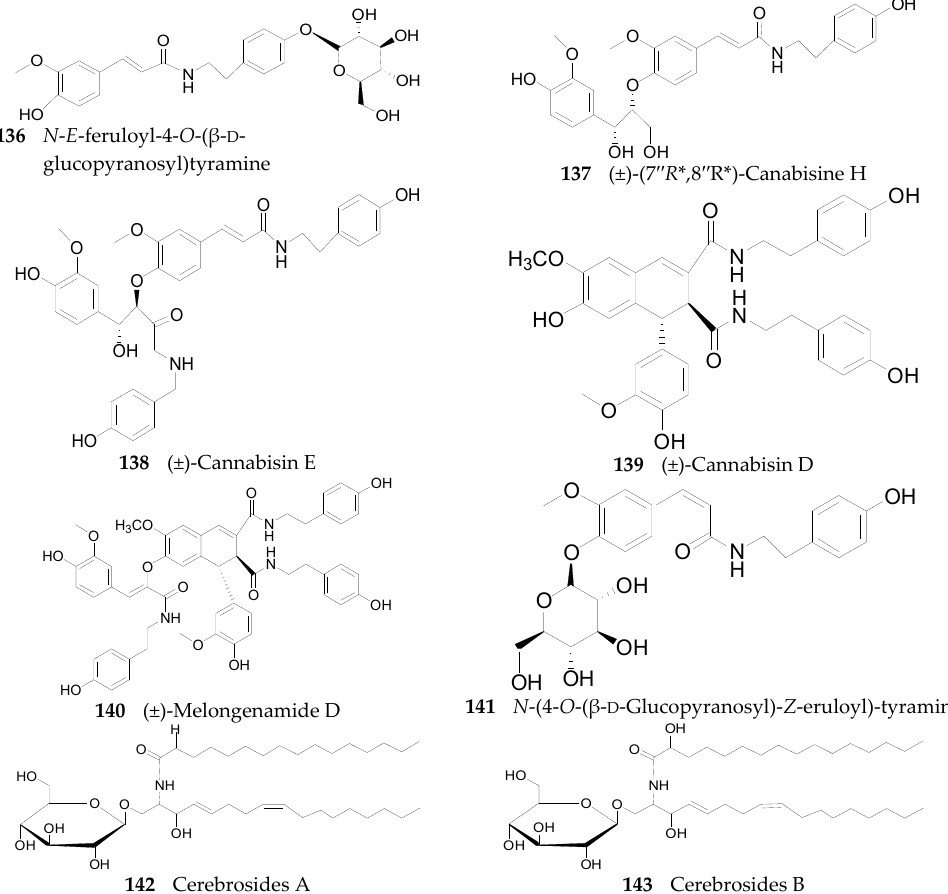
Figure 8. Chemical structures of compounds 107 – 143 .